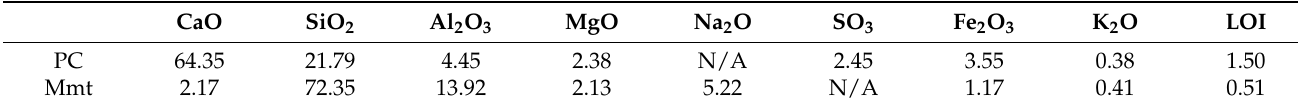
Table 1. Chemical composition (wt.%) of the cement and